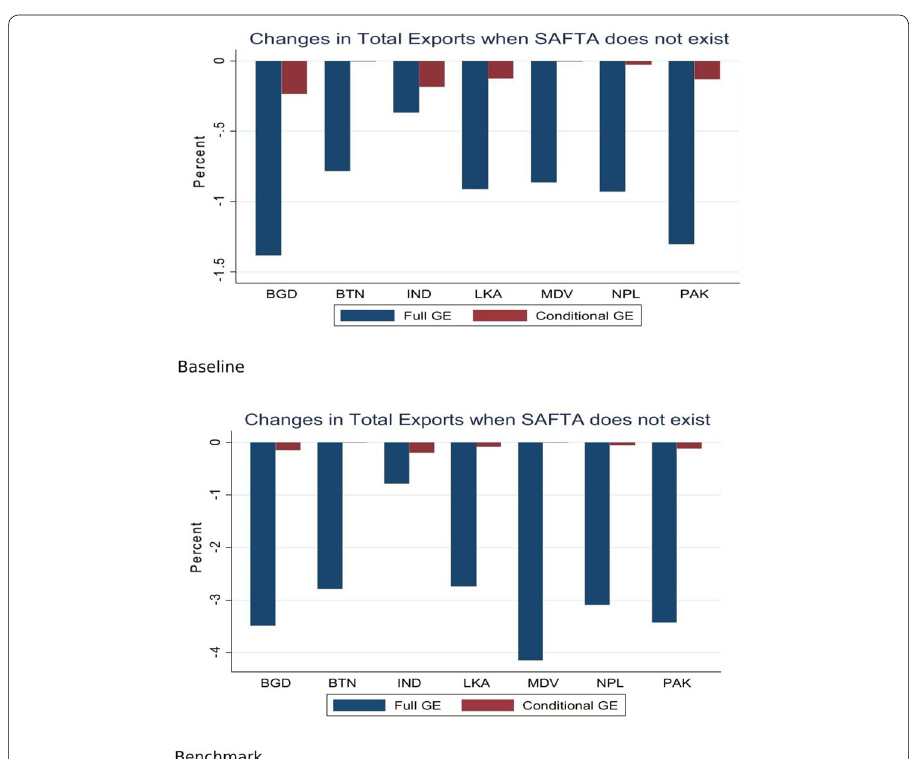
Figs. 3 and 4 Conditional and full GE impact of SAFTA on member countries’ export (baseline and